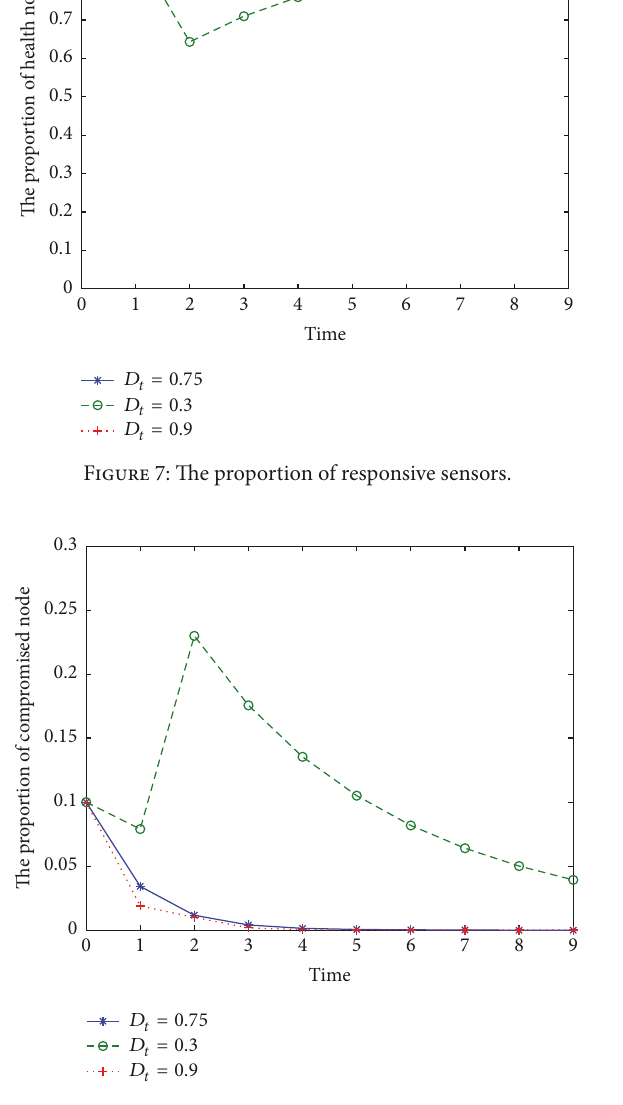
Figure 8: The proportion of compromised sensors.